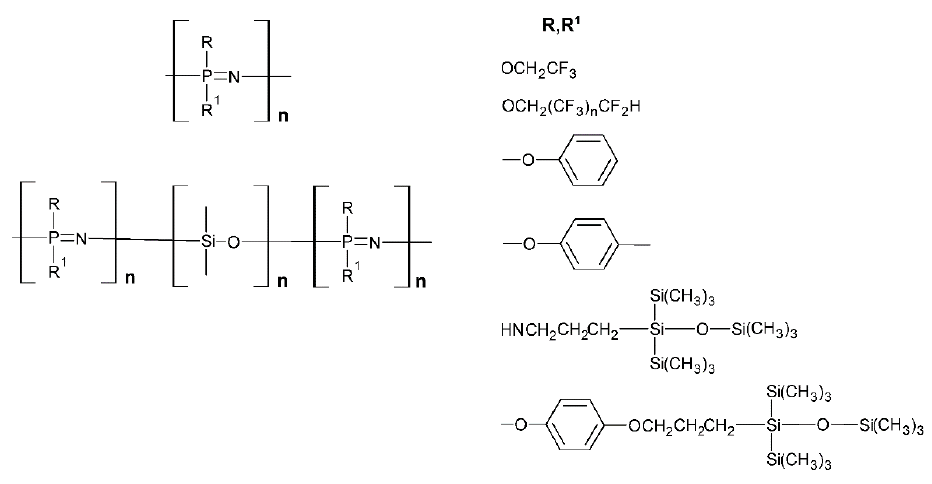
Figure 23. Hydrophobic polyphosphazenes.